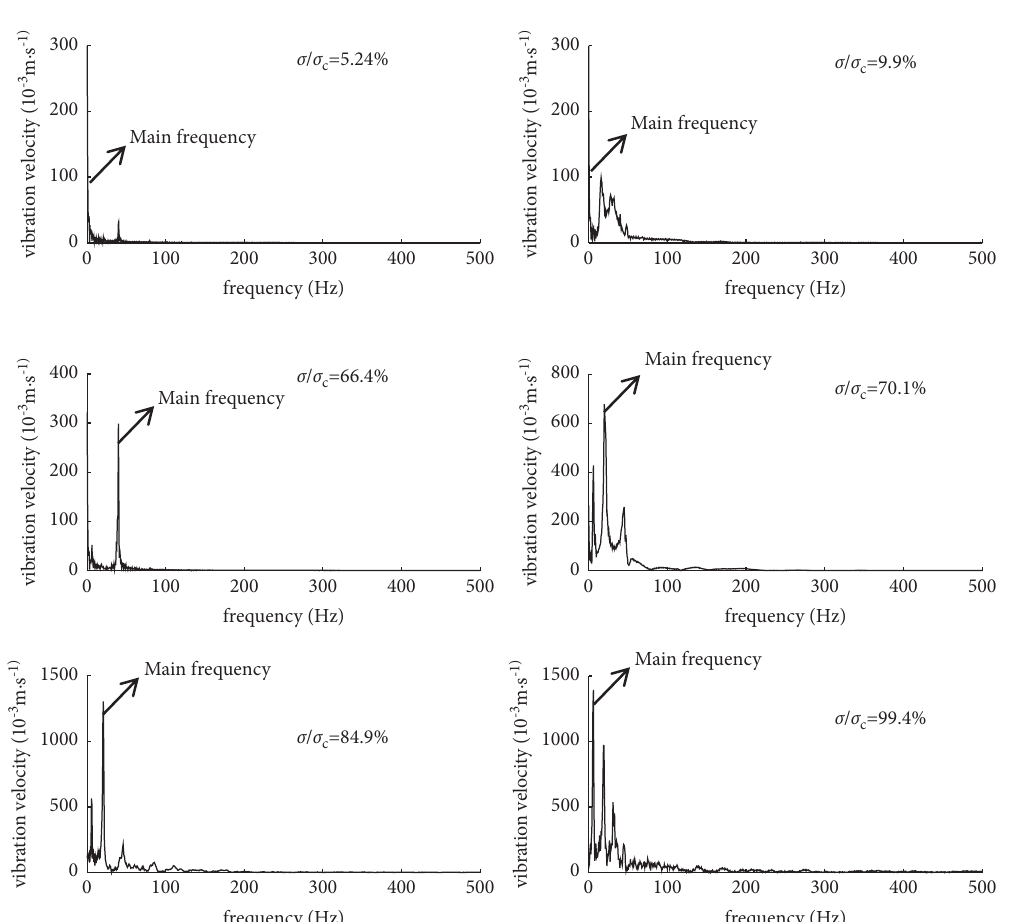
Figure 9: Microseismic signals spectrum of sandstone in different stages when the loading rate is